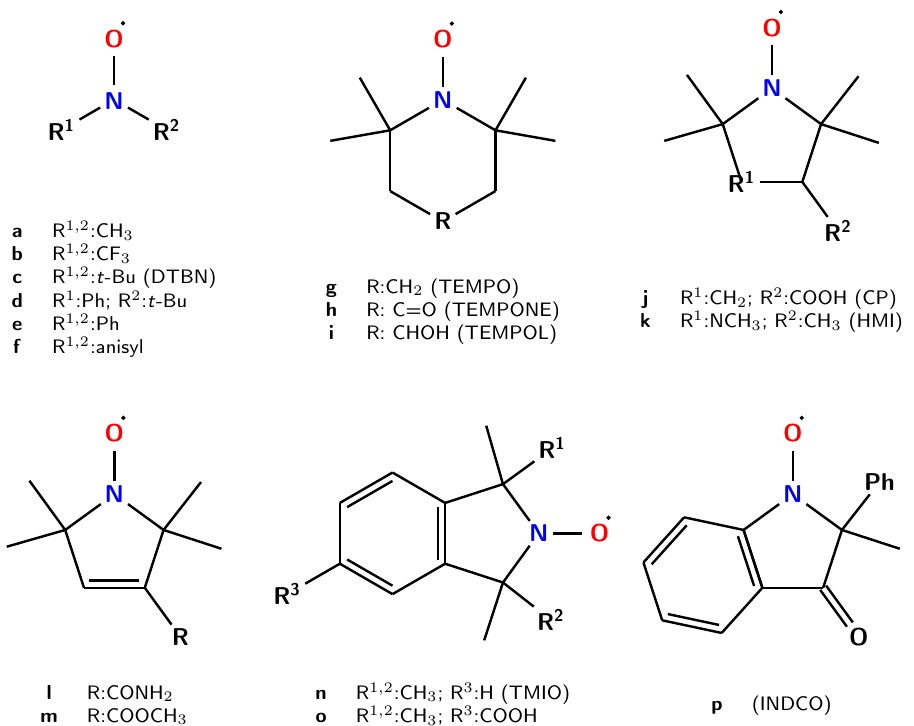
Figure 1. Structure and labeling of the investigated nitroxides.